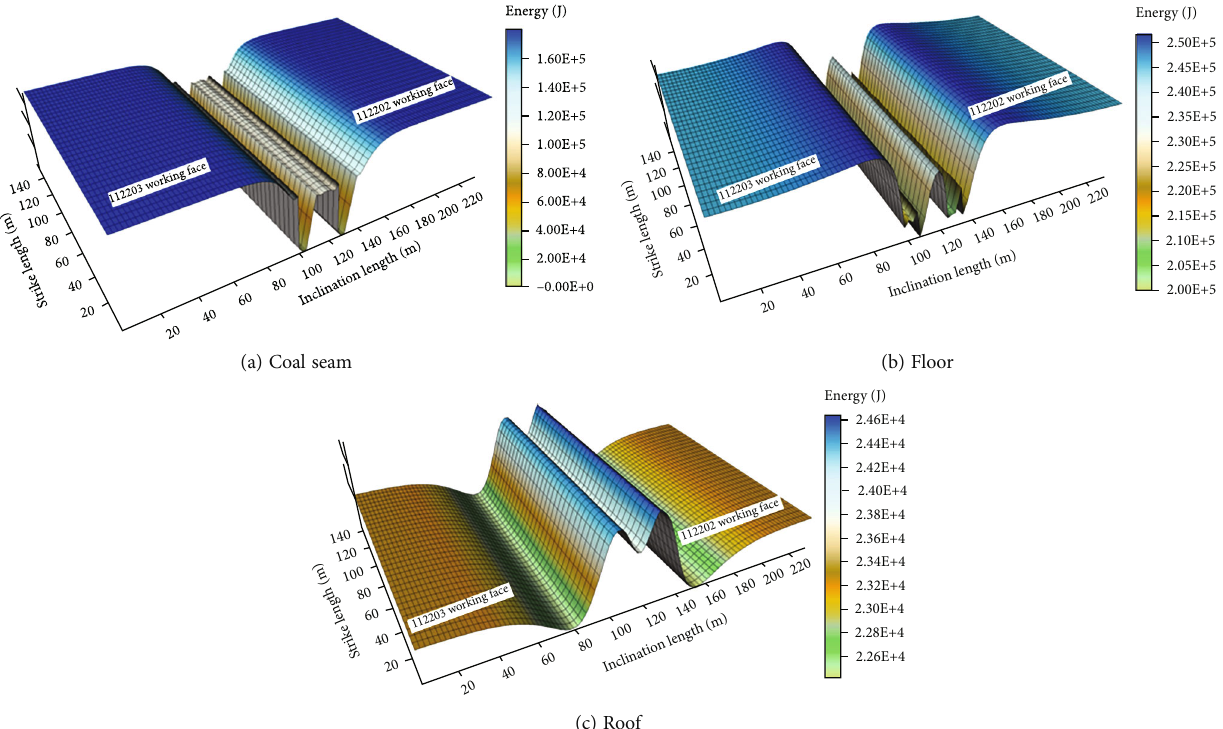
Figure 10: Energy distribution characteristics of the surrounding rock in hydraulic fracturing roof cutting of the roadway during double roadway excavation.